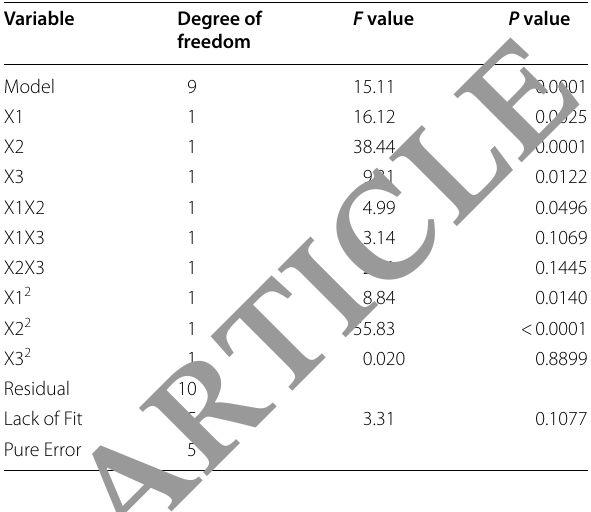
Table 7 Effects and statistical analysis of